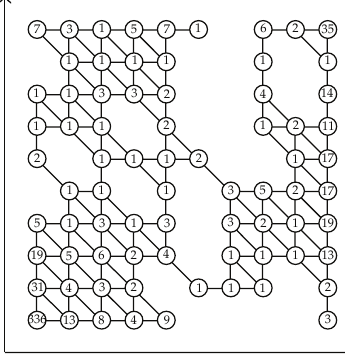
Figure 10: Simplices of the Wisconsin breast cancer data.